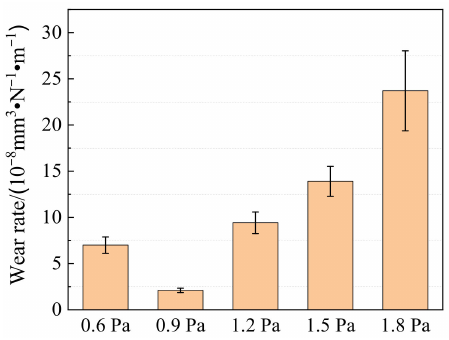
Figure 9. Average wear rate of different deposition